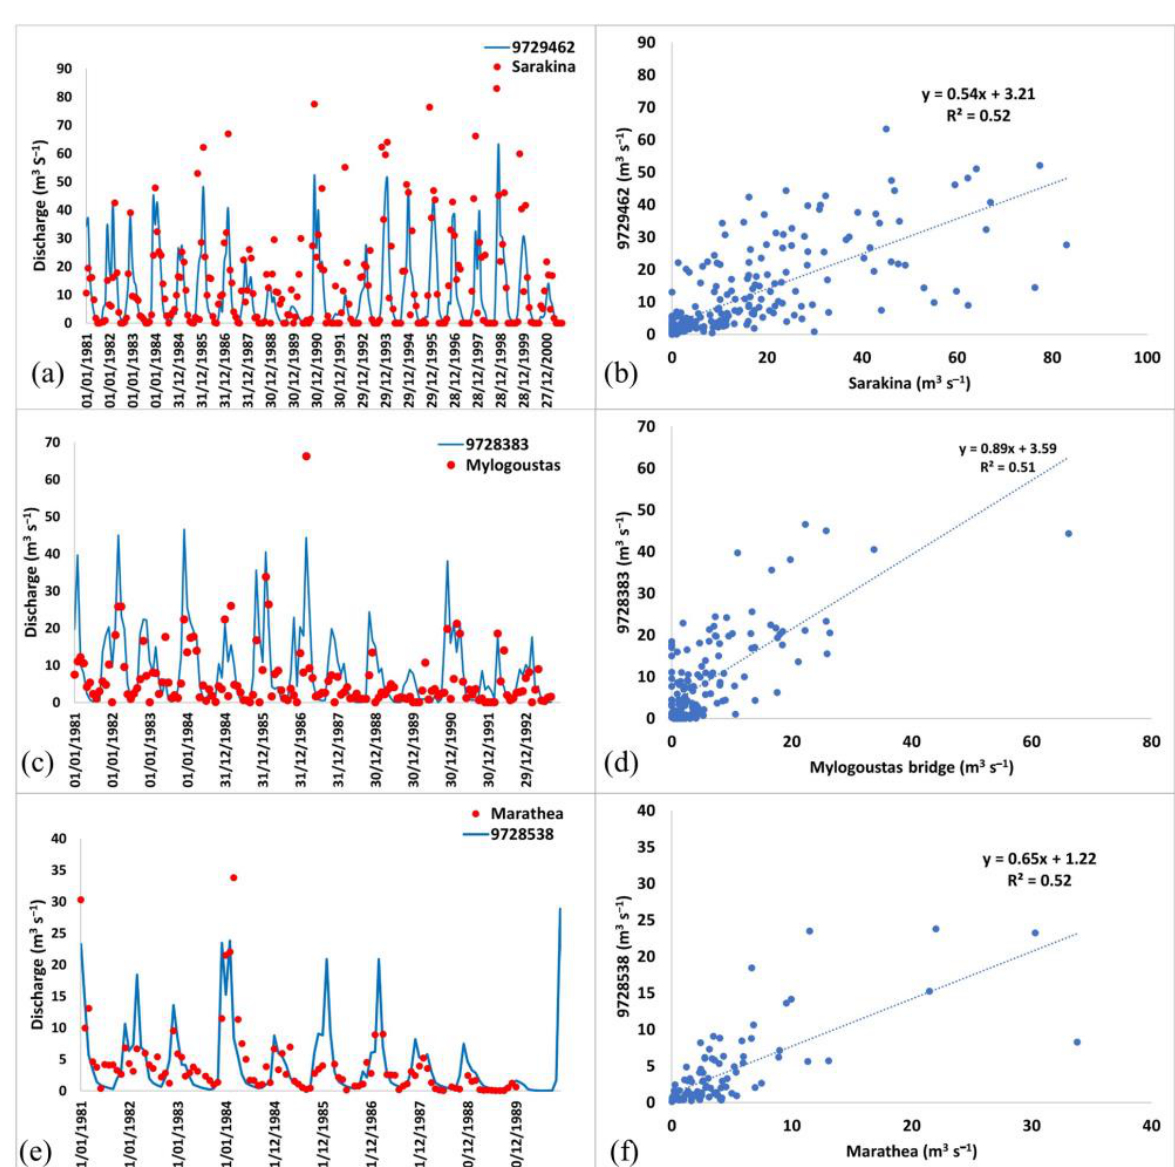
Figure A1. Simulated and measured discharge (m 3 s −1 ) values and correlations of ( a , b ) PINUP — Sarakinas bridge, ( c , d ) TITAR — Mylogoustas bridge, and ( e , f ) MREMA — Marathea station.